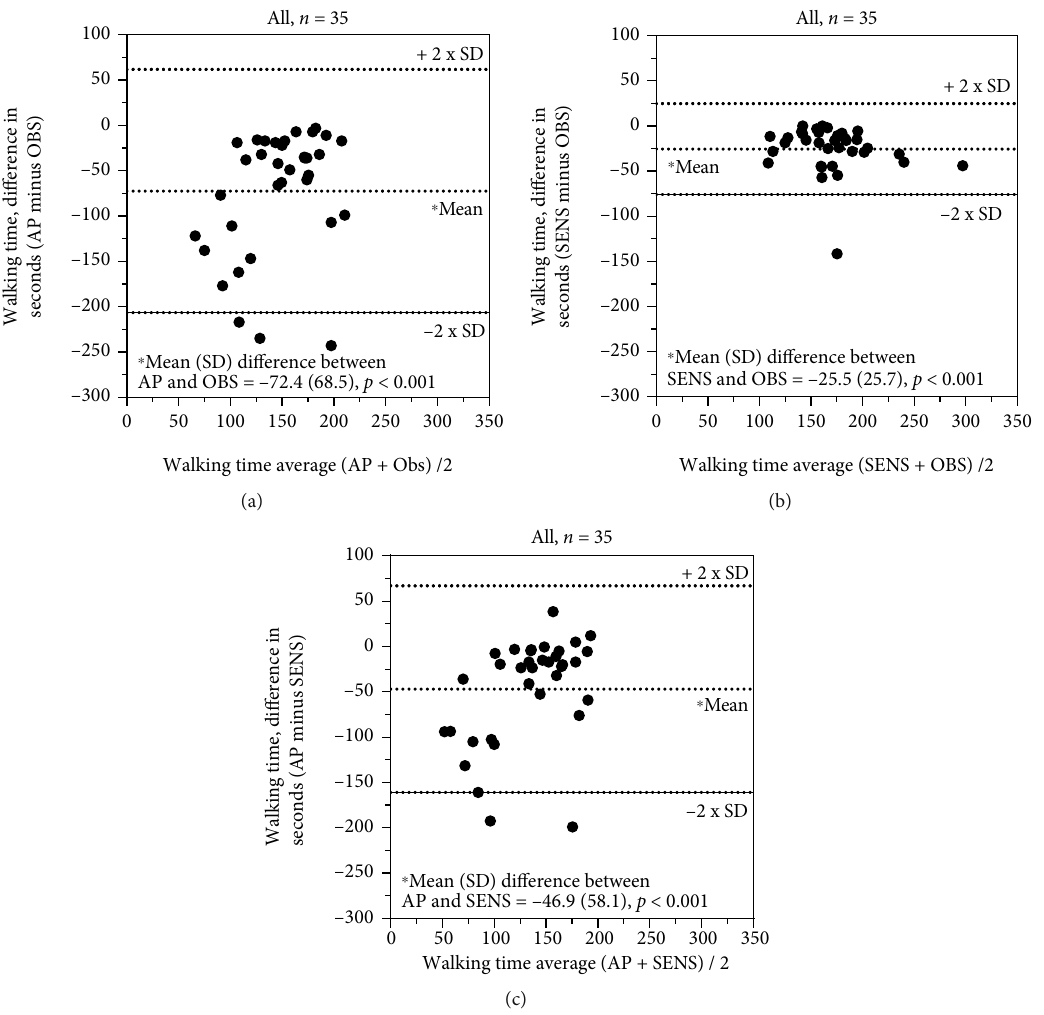
Figure 4: (a – c) Recording of walking time: comparison between ActivPAL3 ™ , SENS motion®, and direct